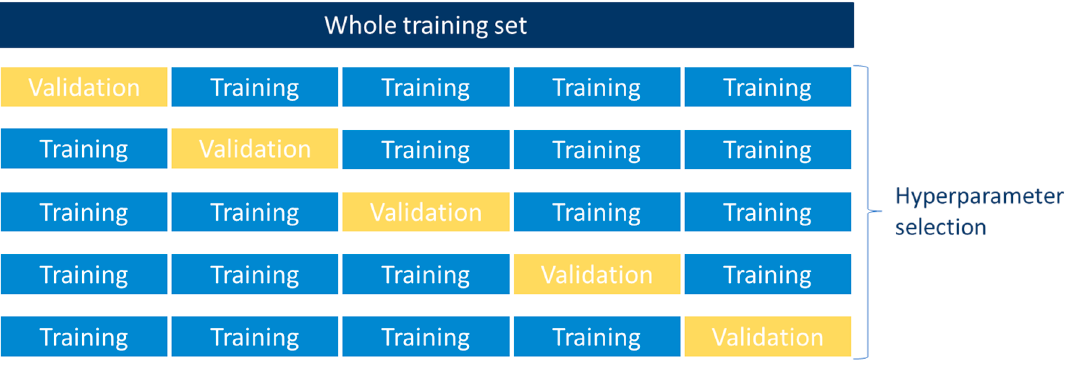
Figure 4. 5-fold cross validation for hyperparameter tuning.